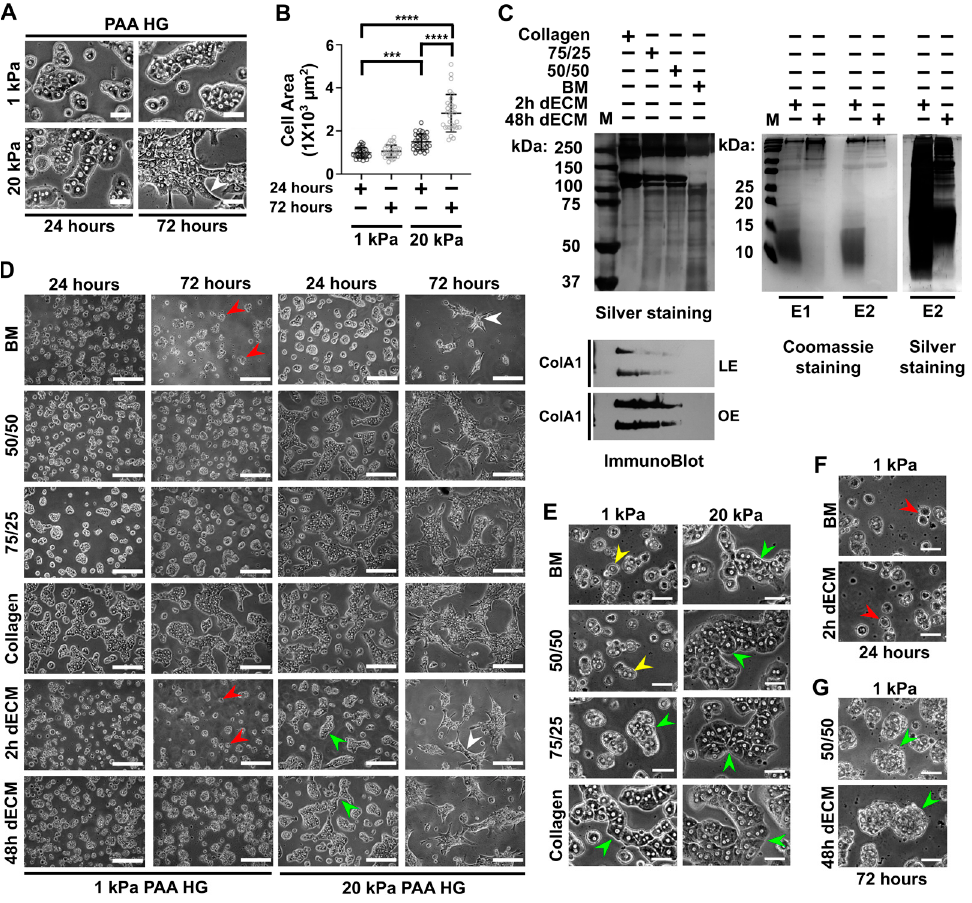
Figure 1. Collagen type I is necessary for cell adhesion and aggregation in rat primary hepatocytes cultured on soft polyacrylamide hydrogels (PAA HGs). ( A ) Magnifications of representative differential interference contrast (DIC) images of primary hepatocytes cultured on soft (1 kPa) and stiff (20 kPa) polyacrylamide hydrogels (PAA HGs) conjugated with collagen type I after 24 and 72 h of culture. Scale bar: 50 μ m. ( B ) Quantitative analysis and comparison of cell area of hepatocytes cultured on soft and stiff PAA HGs at 24 h and 72 h of culture. Data are represented as mean ± standard deviation (SD) of a representative of 3 independent experiments, **** p < 0.0001, *** p < 0.001 ( C ) Silver staining of SDS-PAGE of Matrigel basement membrane-associated matrix (BM) and collagen type I at different proportions (left) and decellularized liver matrices (dECM) extracted after 2 h and 48 h of digestion (right). Lower panel: collagen type I immunoblotting in collagen and BM mixtures (below). Membranes low-exposed (LE) and over-exposed (OE) (lower panel). In addition, Coomassie staining of 2 h and 48 h dECM of 2 independent experiments (E1 and E2) ran in parallel. ( D ) Primary hepatocytes cultured on 1 kPa and 20 kPa PAA HGs conjugated with different collagen I/BM proportions and decellularized matrix extracts (dECM) at 24 h and 72 h of culture. Images were obtained from a 20× objective. Scale bar: 200 μ m. ( E ) Magnifications of differential interference contrast (DIC) images of primary hepatocytes cultured on soft and stiff PAA HGs at 72 h of culture. Collagen and BM were conjugated at different proportions. Scale bar: 50 μ m. ( F – G ) Magnifications of DIC images of hepatocytes cultured on soft PAA HGs conjugated with different extracellular matrices (ECMs) at 72 h of culture. ECM mixtures: BM, 100% matrigel; 50/50, 50% collagen type I plus 50% BM; 75/25, 75% collagen type I plus 25% BM; collagen, 100% collagen type I; 2h dECM, dECM after 2 h of digestion; 48h dECM, ECM after 48 h of digestion; M, molecular weights. Scale bar: 50 μ m. Aggregates of primary hepatocytes: green arrowheads; apoptotic bodies: red arrowheads; individual hepatocytes: yellow arrowheads; transformed hepatocytes: white arrowheads.